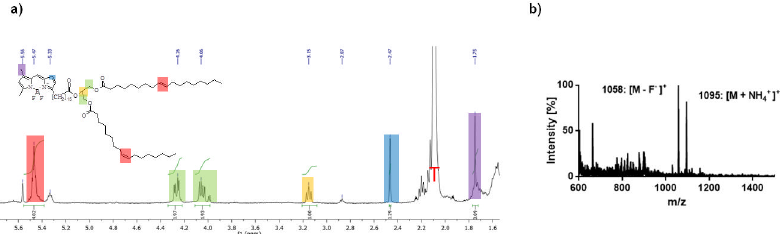
Fig 1. BDP-TG analysis a 1 H-NMR of BD-TG in toluene-d5,red T corresponds to the toluenepeek b ESI-MS of BDP-TG with NH 4 OAC in Chloroform/MeOH 50:50.